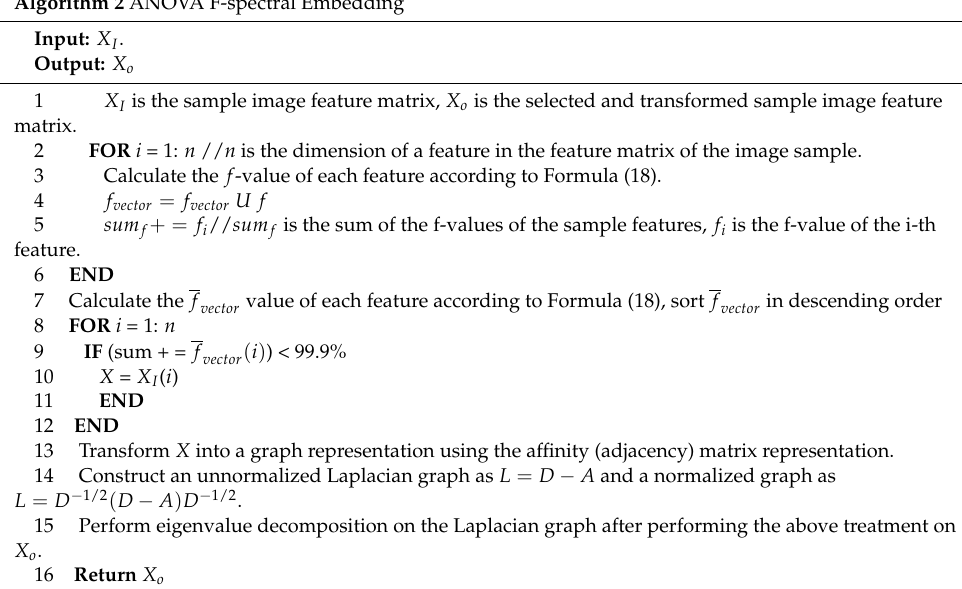
Algorithm 2 ANOVA F-spectral